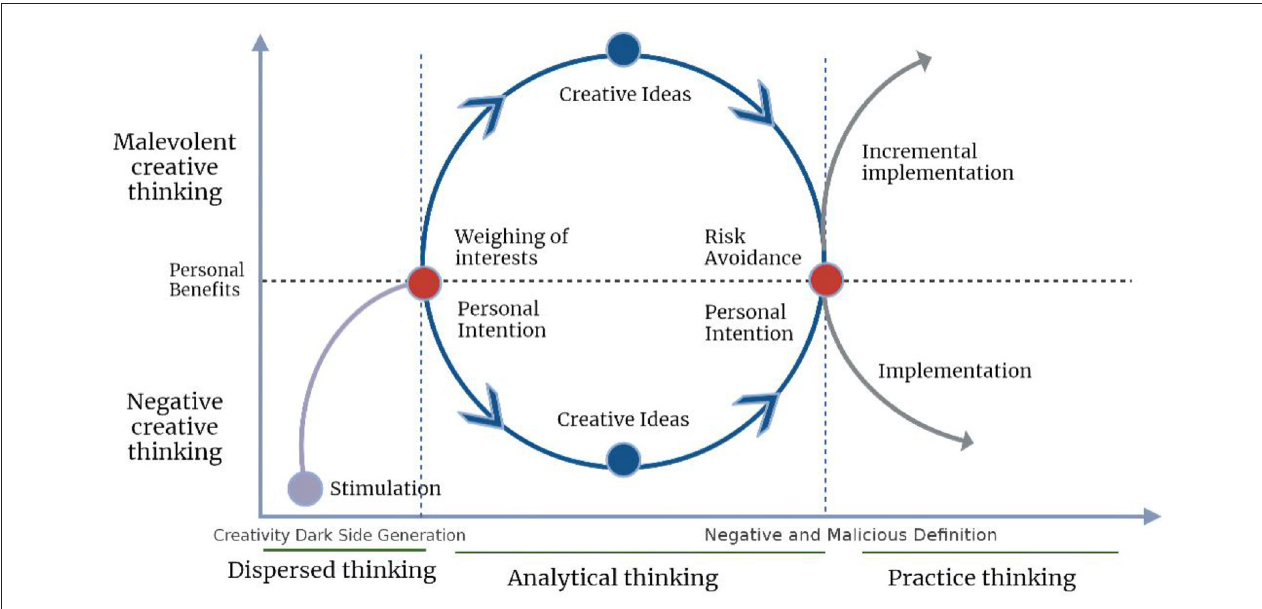
FIGURE 1 | Negative-malevolent thinking interconnection model